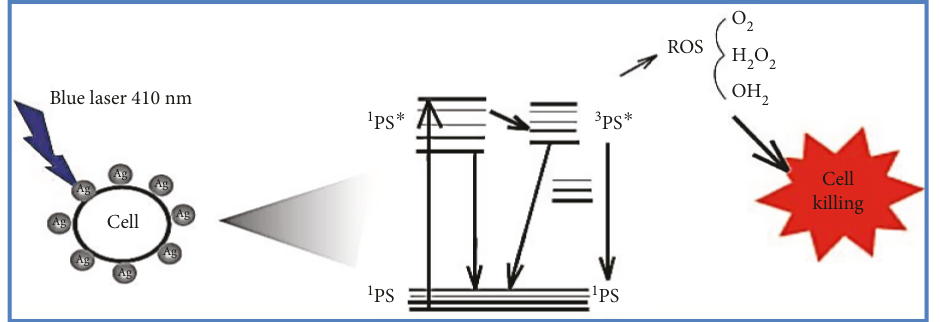
Figure 9: Simpli fi ed Jablonski diagram showing how Ag-NPs can generate di ff erent ROS able to kill bacteria upon illumination at 410 nm; 1 PS: singlet state; 1 PS ∗ : excited singlet state; 3 PS ∗ : excited triplet